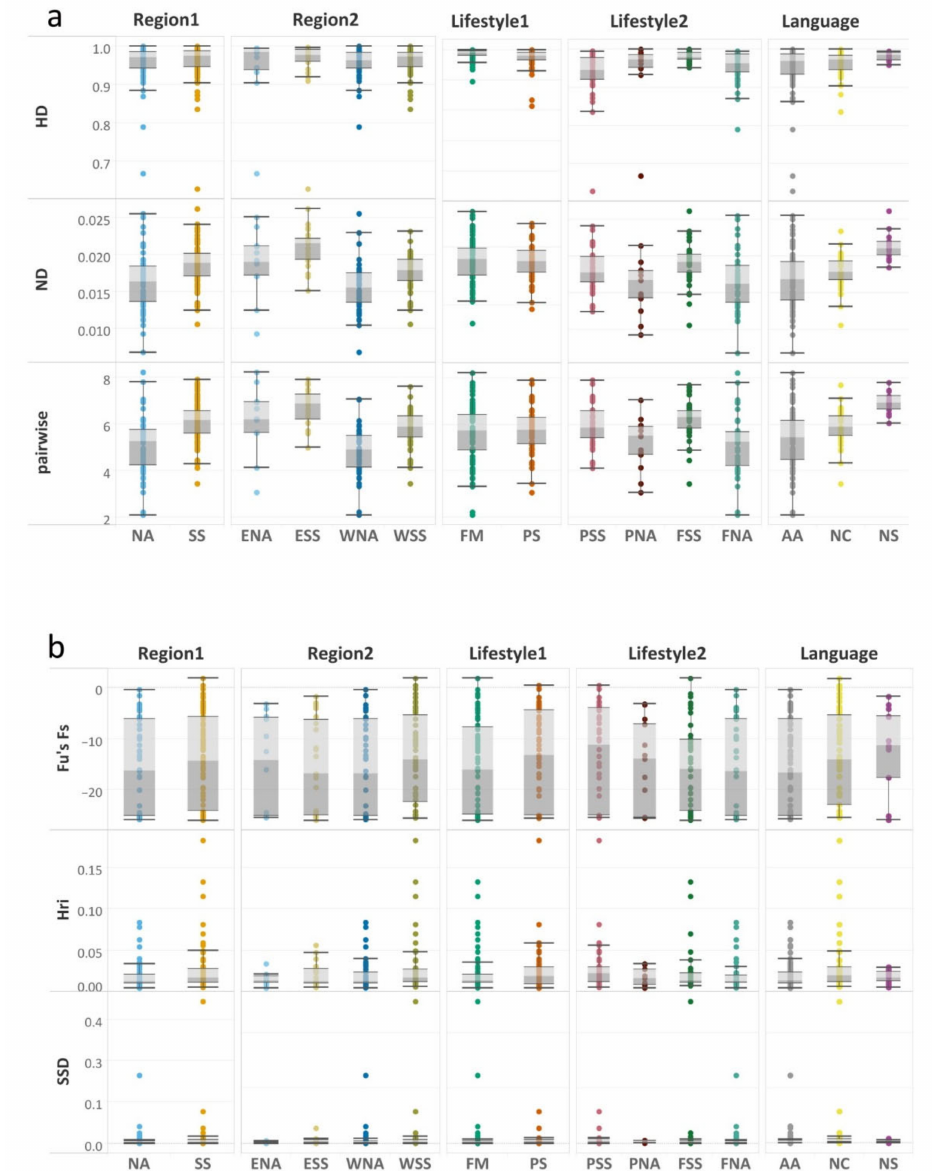
Figure 2. Boxplots representing diversity values of basic standard and molecular indices in five groups defined by subsistence strategy, language, and geographic region. ( a ) HD—haplotype diversity, ND—nucleotide diversity; pairwise—the mean number of pairwise differences; ( b ): Fs—Fu’s; Hri– Harpending’s raggedness index; SSD—the sum of squared deviations. Grouping label abbreviations: Region1: NA North Africa, SS Sahel/Savannah belt, Region2: ENA Eastern North Africa, ESS Eastern Sahel/Savannah belt, WNA Western North Africa, WSS Western Sahel/Savannah belt. Lifestyle1: PS Pastoralists, FM Farmers, Lifestyle2: PSS pastoralists of Sahel/Savannah belt, PNA pastoralists of North Africa, FSS farmers of Sahel/Savannah belt, FNA farmers of North Africa. Language: AA Afro-Asiatic, NC Niger-Congo, NS Nilo-Saharan. The color palette is set according to the defined groups. The line dividing boxplots into two parts represents the median of data for the variable concerned. The ends of the box indicate the upper (Q3) and lower (Q1) quartiles. The difference between quartiles 1 in light grey and 3 in grey indicates the interquartile range (IQR). The top and bottom lines show the maximum and minimum values. Dots (or other markers) beyond the extreme line indicate potential